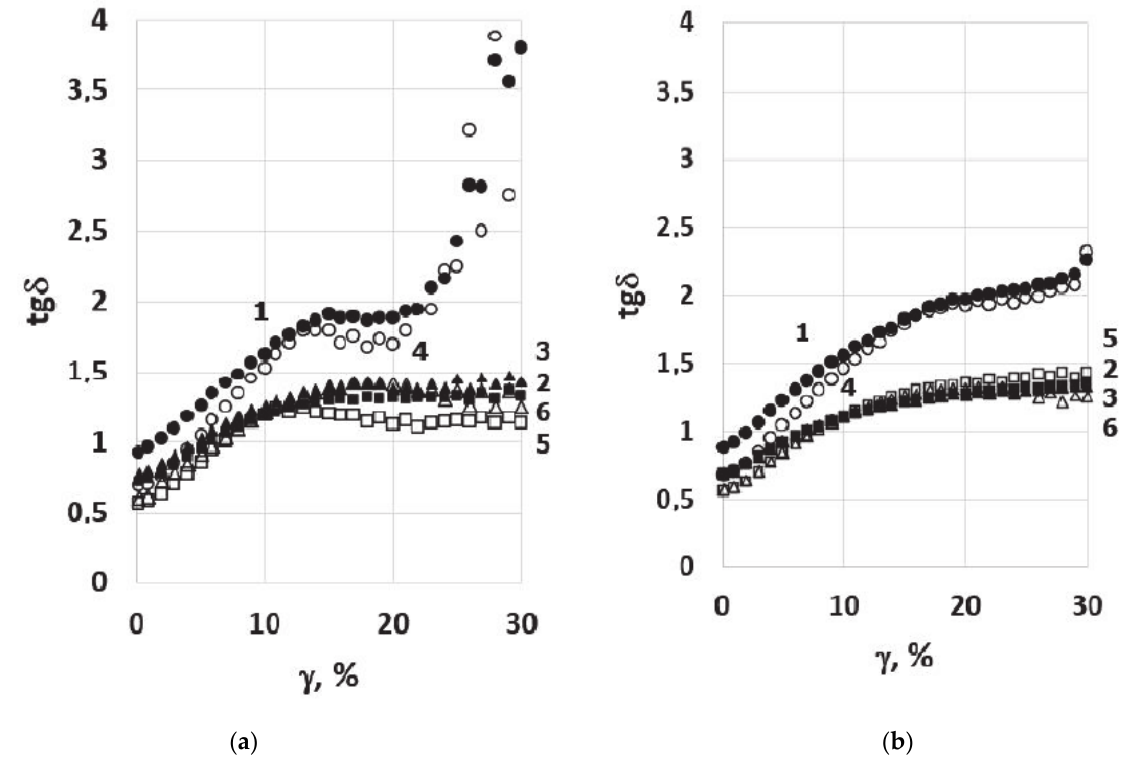
Figure 8. Plots of the tg δ versus shear strain ( γ ) in the LAS test at temperature 16 (1, 2, and 3) and 7 ◦ C (4, 5, and 6) for Bit-A ( a —1 and 4); MB-A(0) ( a —2 and 5); MB-A(20) ( a —3 and 6); Bit-B ( b —1 and 4); MB-B(0) ( b —2 and 5); MB-B(5) ( b —3 and 6).